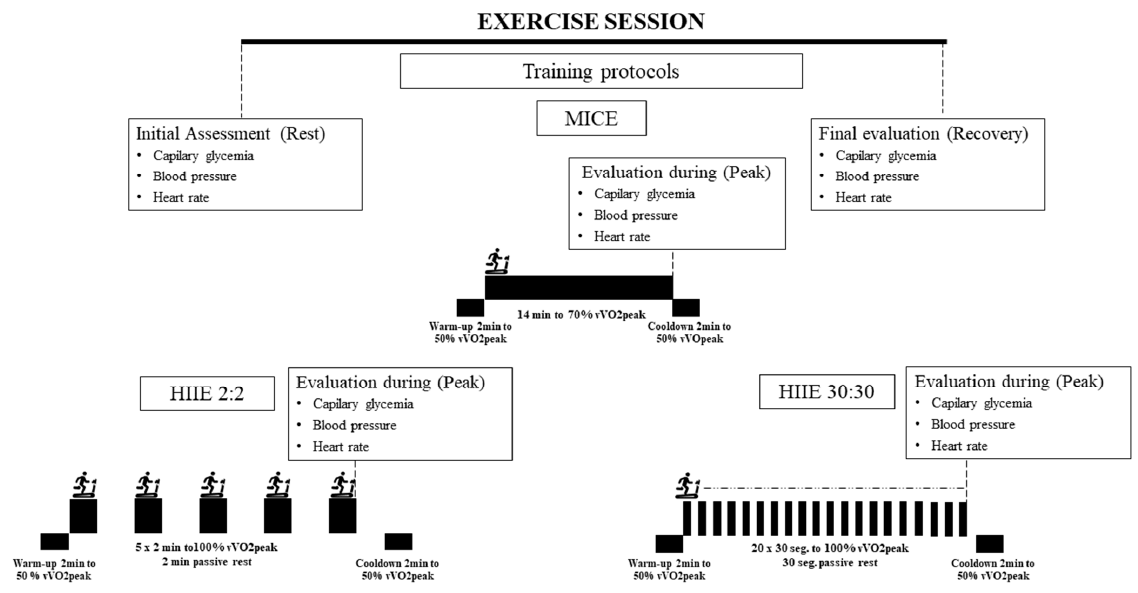
Figure 1. Diagram of training protocols in the session. HIIE: high-intensity interval exercise; MICE: moderate-intensity continuous exercise; vVo2max: velocity relative to the maximum volume of oxygen.